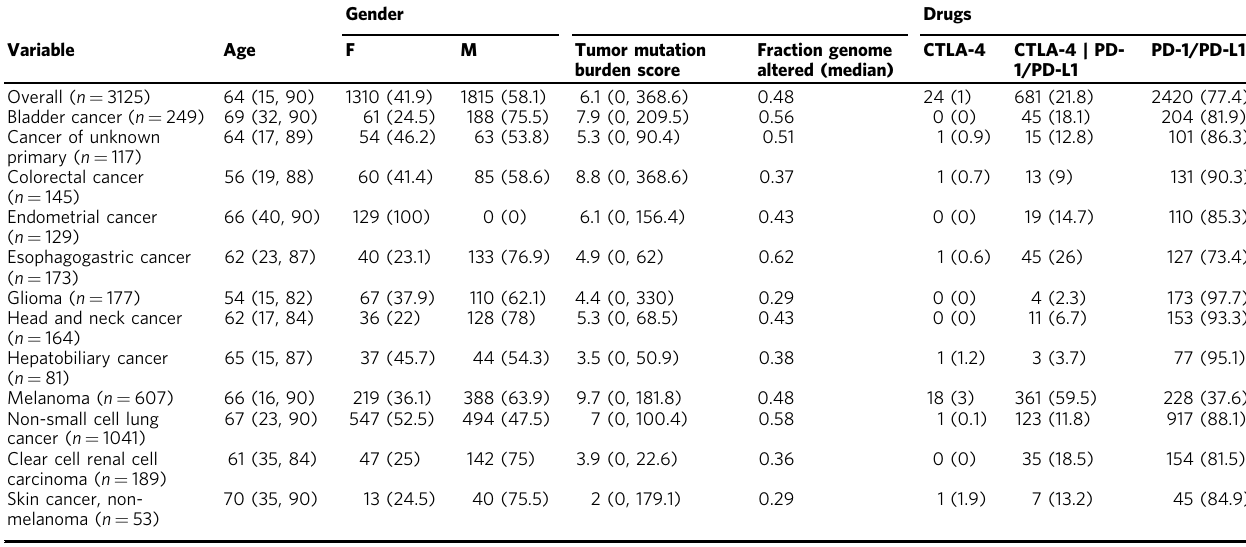
Median (range) reported for continuous variables and % for categorical